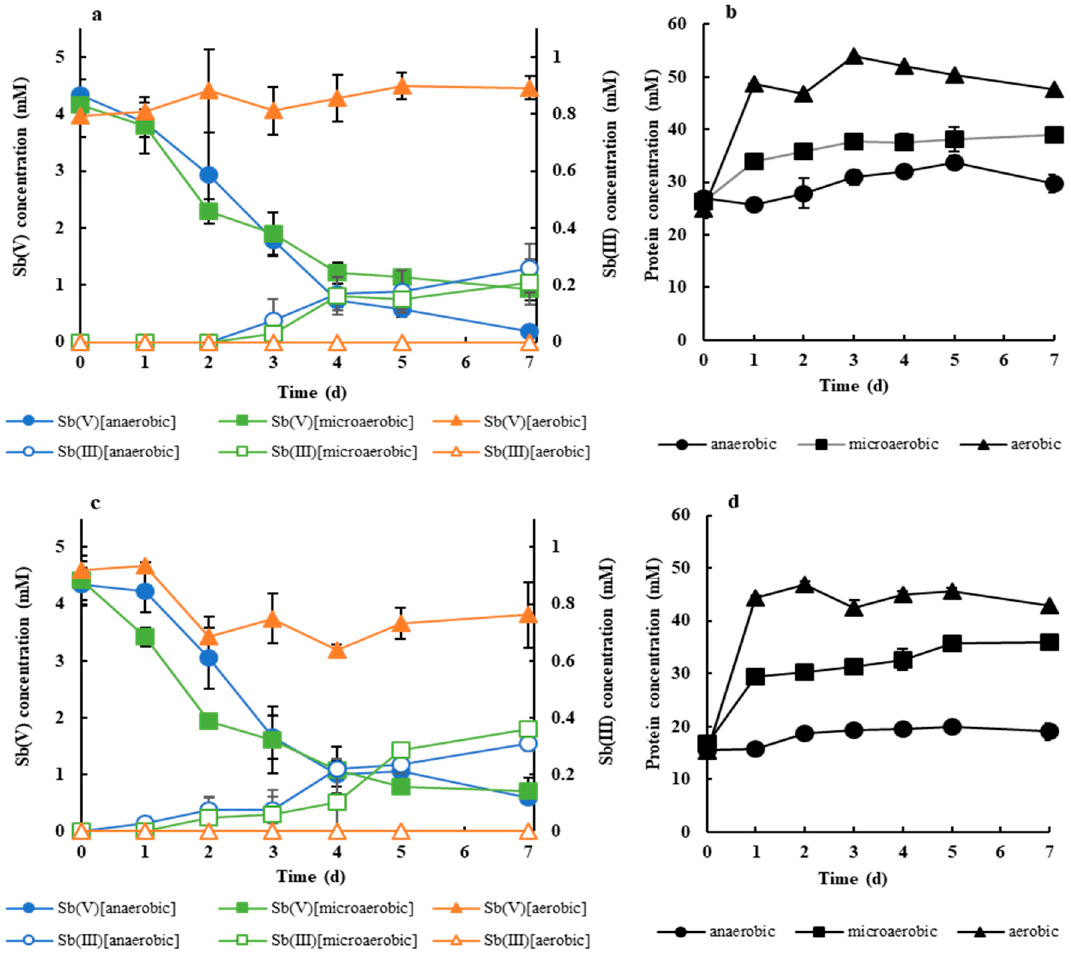
Figure 2. Time course of soluble Sb(V) and Sb(III) ( a , c ) and protein concentrations ( b , d ) during Sb(V) reduction experiments under anaerobic, microaerobic, and aerobic conditions by strains AR-2 ( a , b , respectively) and AR-3 ( c , d , respectively). Error bars represent the standard deviation ( n = 3).